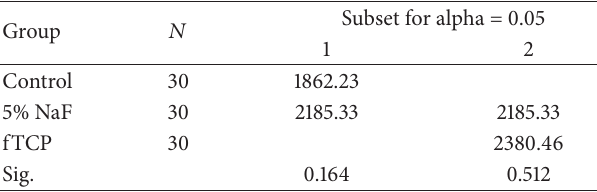
Table 2: Post hoc test indicating the significance of difference in SMH values of different groups ∗